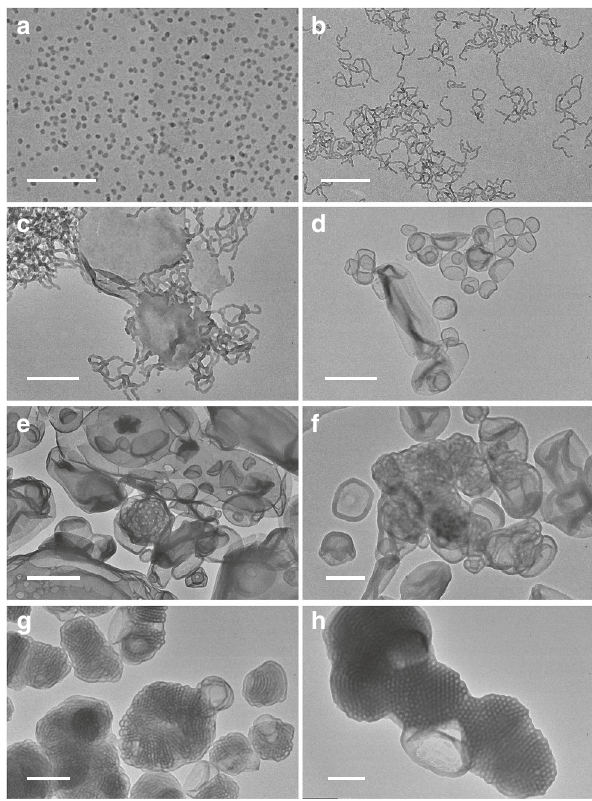
Fig. 2 Transmission electron microscopy (TEM) micrographs of PDMA 29 - b -P(St- alt -PFS) x block copolymer (BCP) particles synthesized in ethanol at 30% w/v and 70 °C. a x = 89 (scale bar: 200 nm), b x = 108 (scale bar: 500 nm), c x = 123 (scale bar: 200 nm), d x = 191 (scale bar: 1 μ m), e x